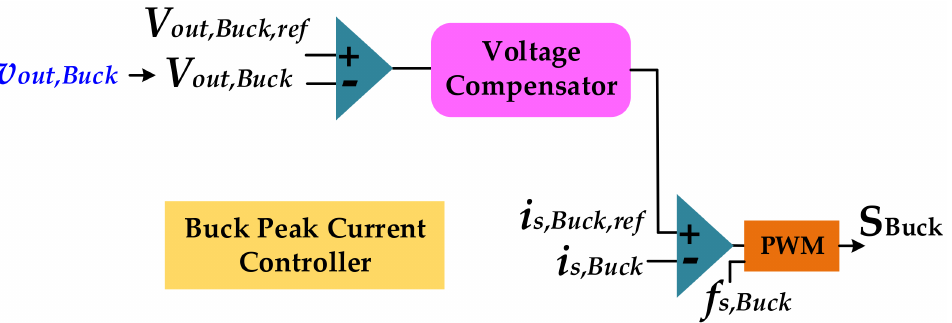
Figure 4. Control scheme of the Buck converter. Peak Current Control